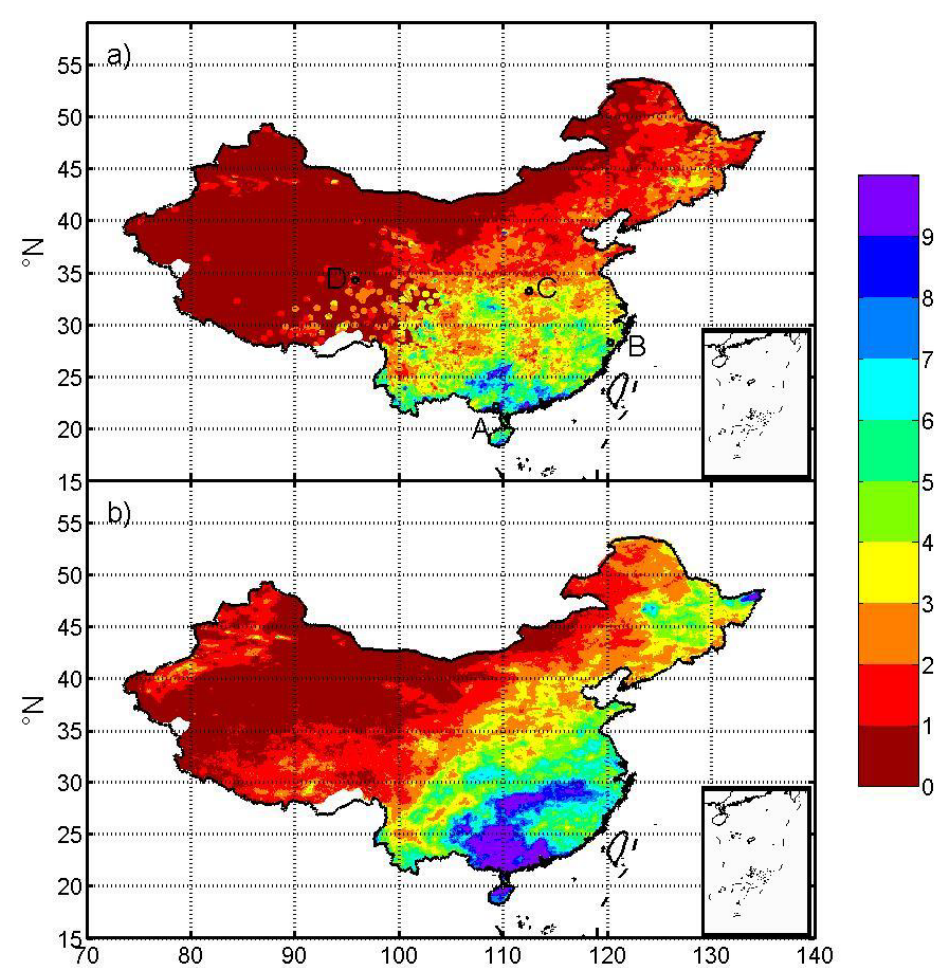
Figure 1. Mean daily precipitation (mm/day) over China for May to September in 2017 from ( a ) CMPA and ( b ) GPM-IMERG-EARLY. The four letters in ( a ) indicate the 0.5° boxes for which the monthly precipitation time series are shown in Figure 5.